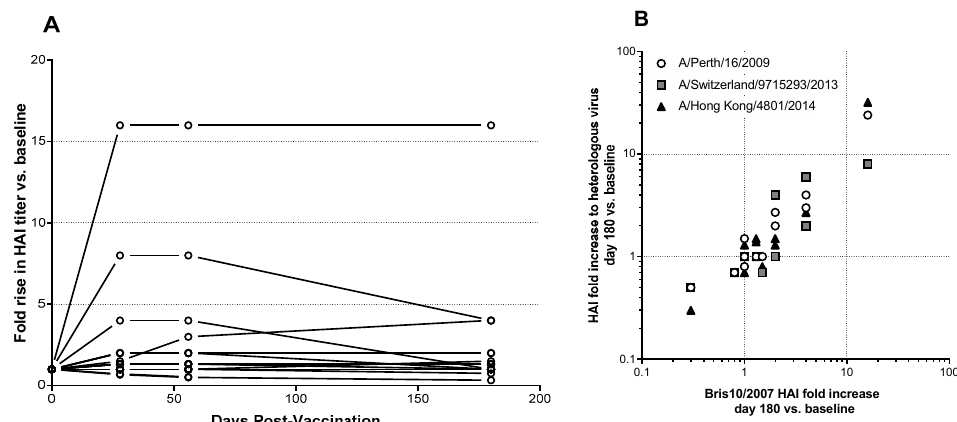
Figure 3. Duration and breadth of response induced by Bris2007 M2SR in high-dose cohort. ( A ) Fold increase in HAI titer against A/Brisbane/10/2007 vs. baseline at days 28, 56 and 180 post-vaccination. Lines represent individual subjects. ( B ) Correlation of fold increase in HAI titer at day 180 vs. baseline for vaccine strain A/Brisbane/10/2007 (clade 1) vs. responses to H3N2 drift strains A/Perth/16/2009 (clade 1), A/Switzerland/9715293/2013 (clade 3c3.a), and A/HongKong/4801/2014 (clade 3c2.a). R-squared values for each correlation ranged from 0.74 to 0.98 ( p < 0.0001).